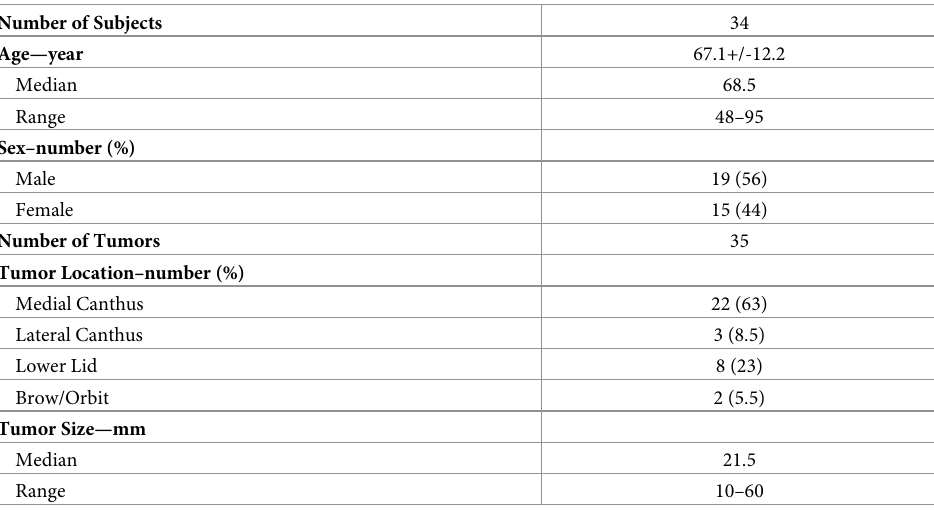
Table 1. VISORB study baseline patient characteristics